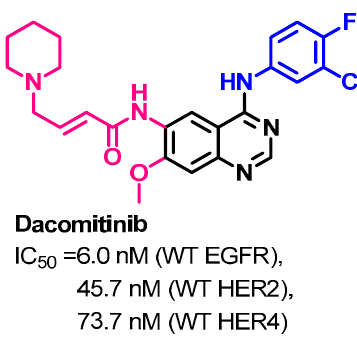
Figure 22. Kinase inhibitory activities of dacomitinib.